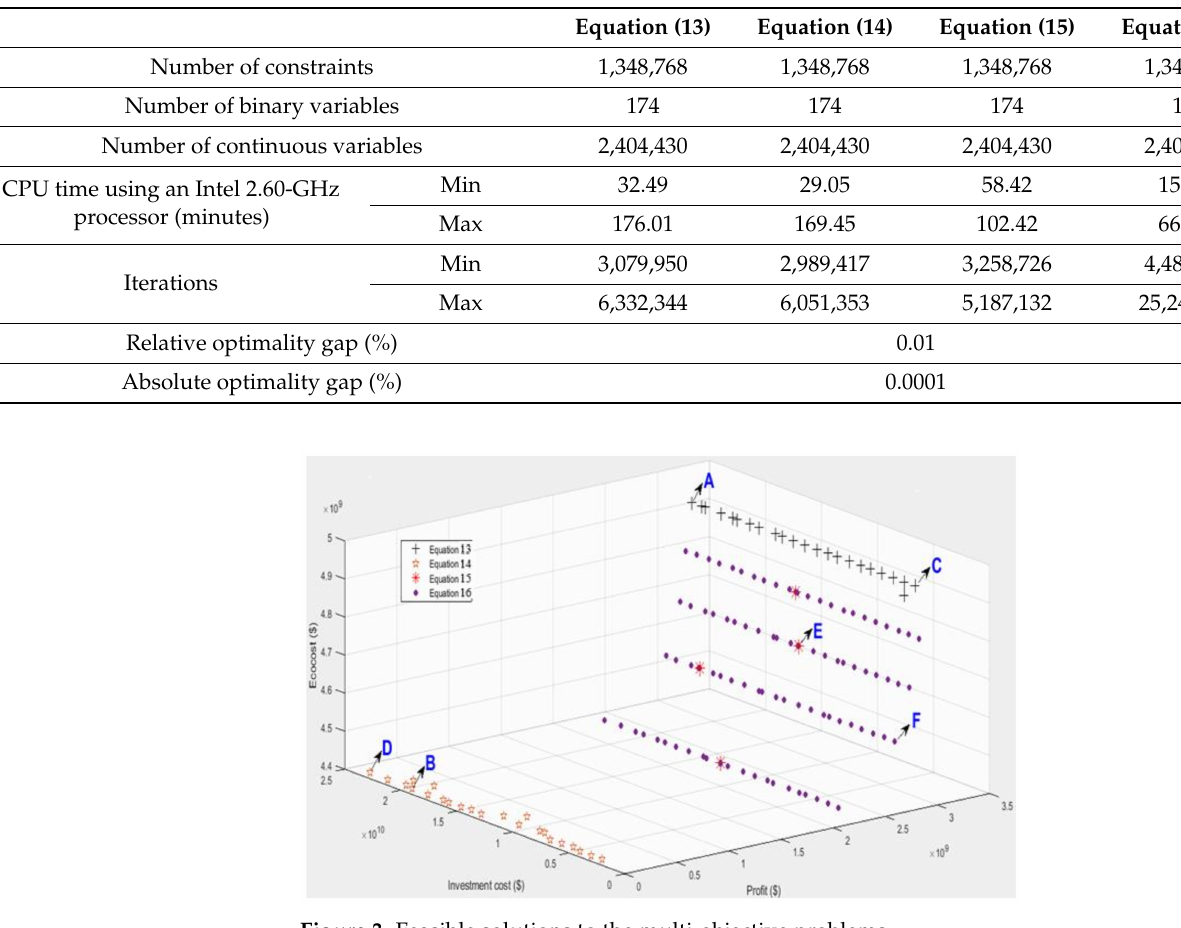
Figure 3. Feasible solutions to the multi-objective